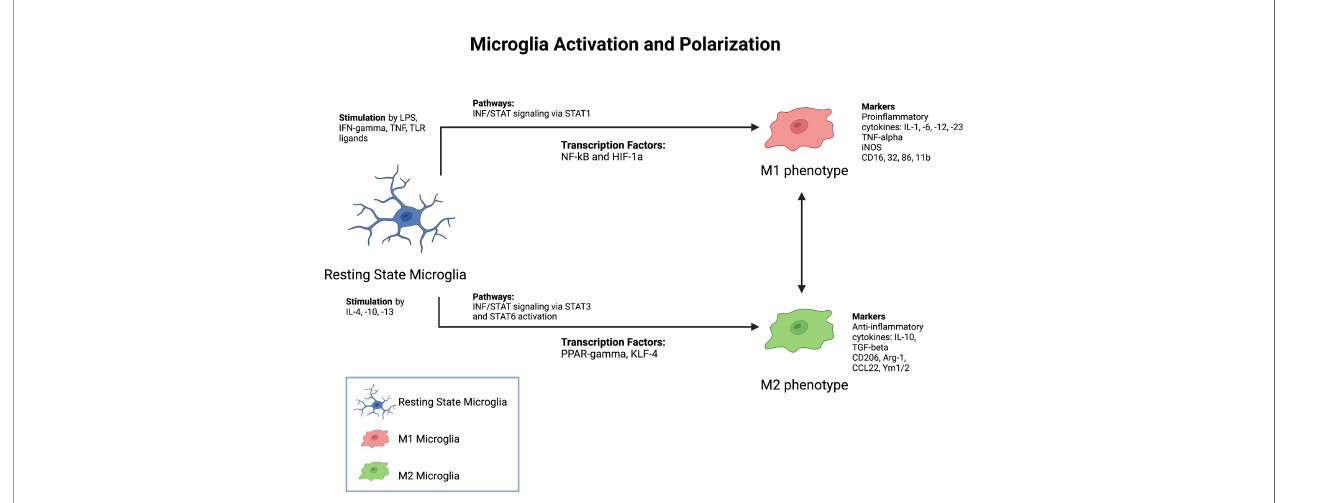
FIGURE 2 | Factors Driving Microglia Activation and Polarization. Summary of major known stimulants, pathways, as well as markers of microglia activation and